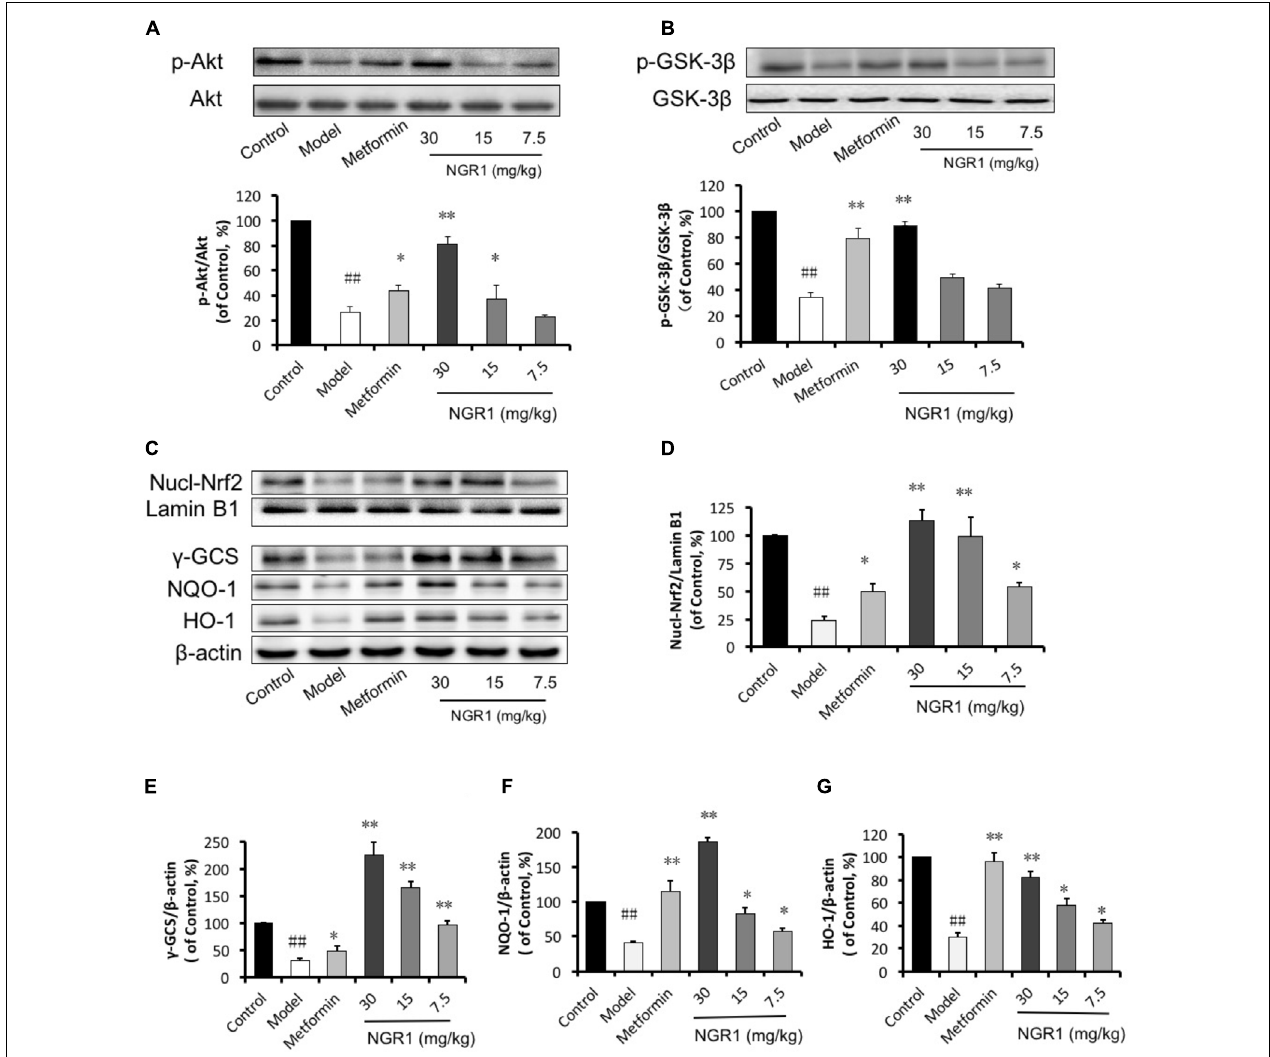
FIGURE 8 | NGR1 activates the Akt-mediated Nrf2 signaling pathway. (A,B) Representative immunoblot images of Akt and GSK-3 β , along with phospho-specific labeling for these proteins, and the immunoblotting results quantified in bar graphs showing that NGR1 promoted Akt and GSK-3 β phosphorylation. (C) Representative immunoblot images of nuclear fractions and (D–G) quantification of the immunoblots shown in bar graphs of Nrf2-mediated phase II anti-oxidant enzymes ( γ -GCS, NQO-1, and HO-1) showed that NGR1 promoted the translocation of Nrf2 to the nucleus. This was associated with the up-regulation of these anti-oxidant enzymes. The quantitative data are presented as the mean ± SD ( n = 3). ## P < 0.01 vs. the Control group, ∗ P < 0.05 or ∗∗ P < 0.01 vs. the Model